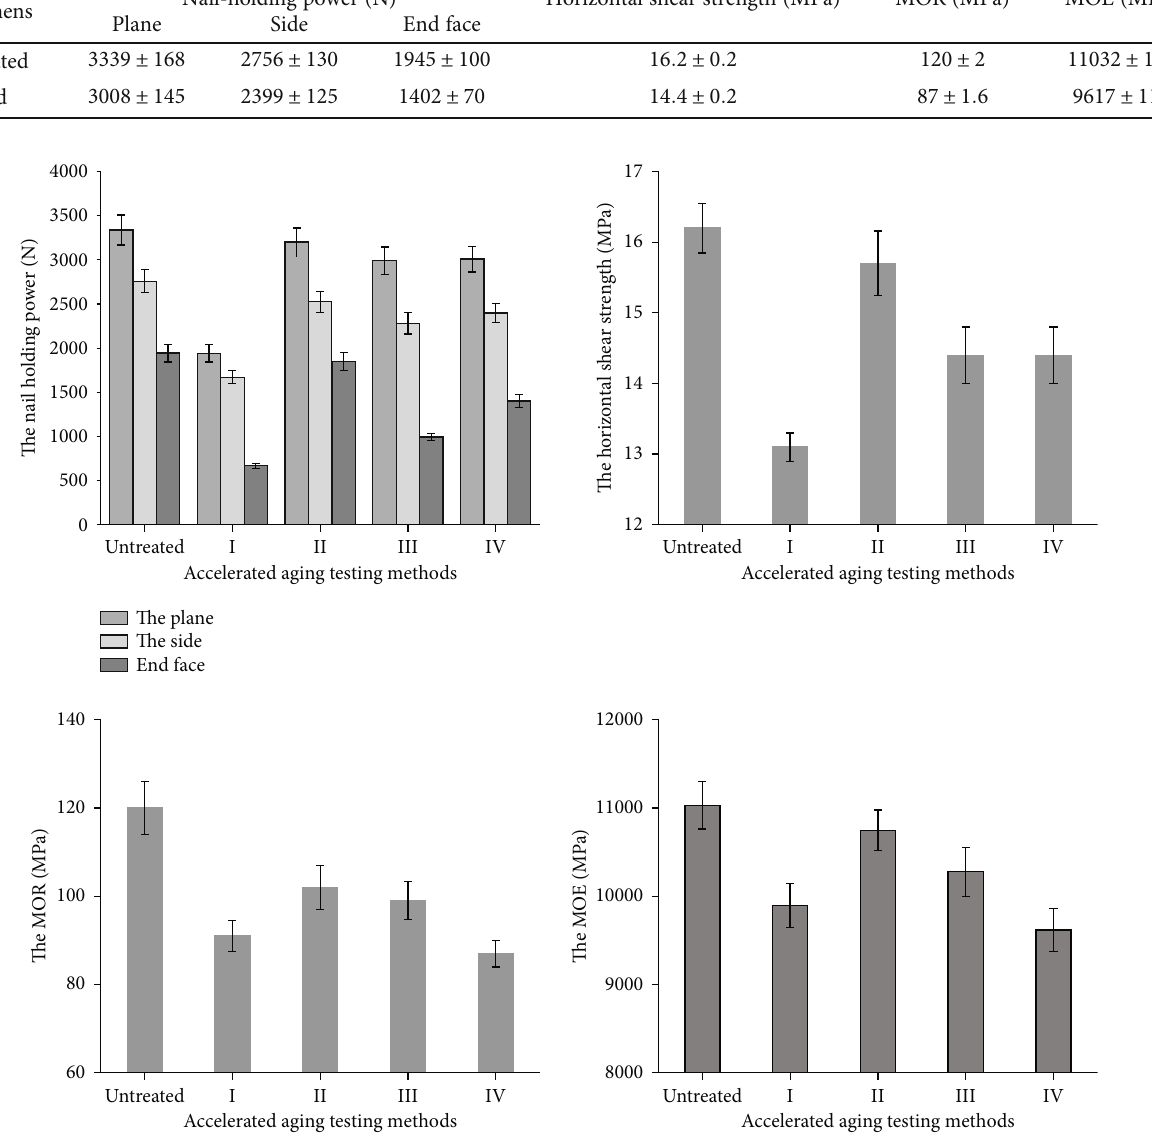
Figure 6: Results of the mechanical properties of bamboo scrimber after the four accelerated ageing testing treatment methods. Table 5: The decrease of bamboo scrimber mechanical properties after the four accelerated ageing testing treatment methods. Degradation of mechanical properties Nail-holding power Plane